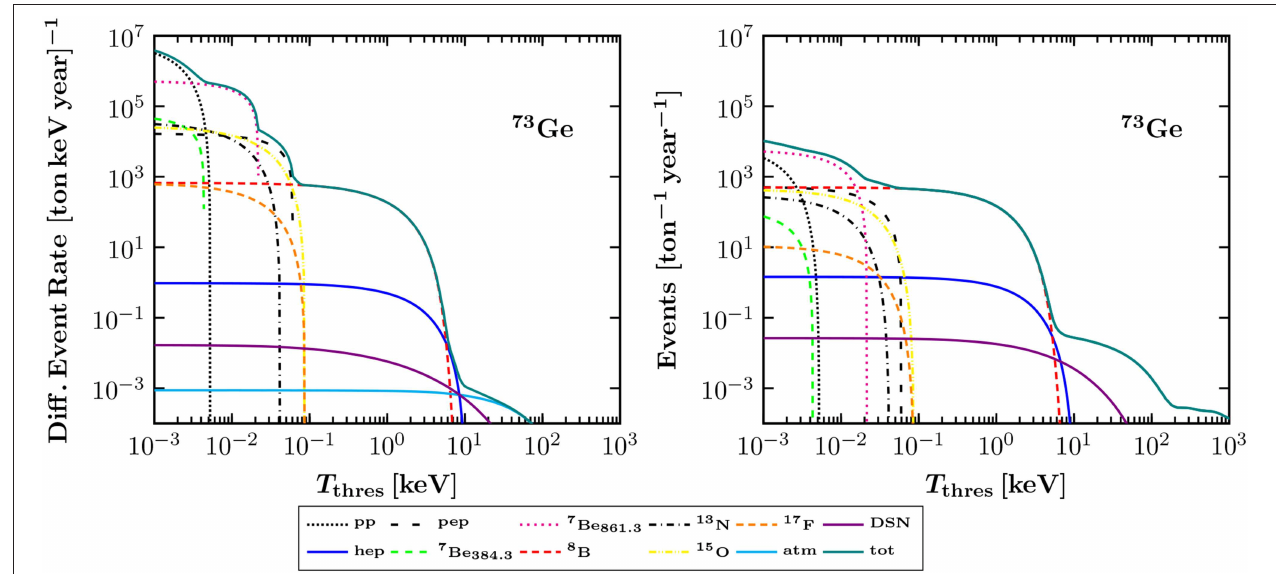
FIGURE 17 | Differential event rate (Left) and total number of events above threshold (Right) expected due to CE ν NS from solar, Atmospheric and DSNB neutrinos at a Germanium detector. Figure adapted from Papoulias et al. [39] under the terms of the Creative Commons Attribution 4.0 International